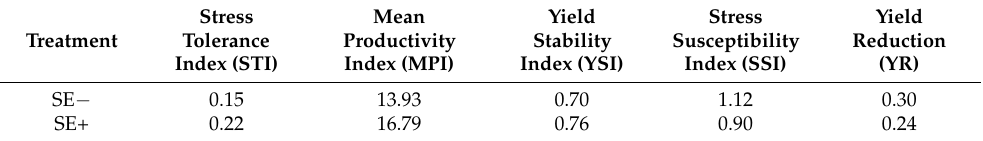
Table 6. Tolerance and productivity of tomato plants as determined by stress